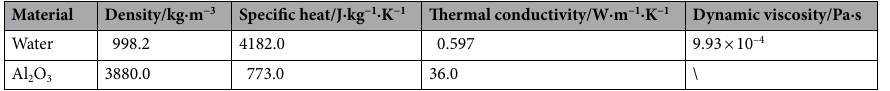
Table 2. Physical properties of materials at 293 K and atmosphere.